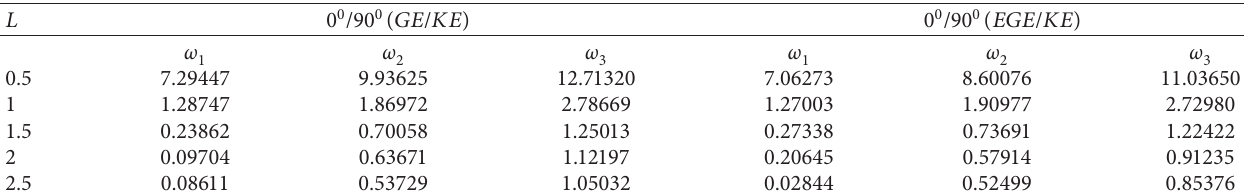
Table 2: Relation between angular frequency ω